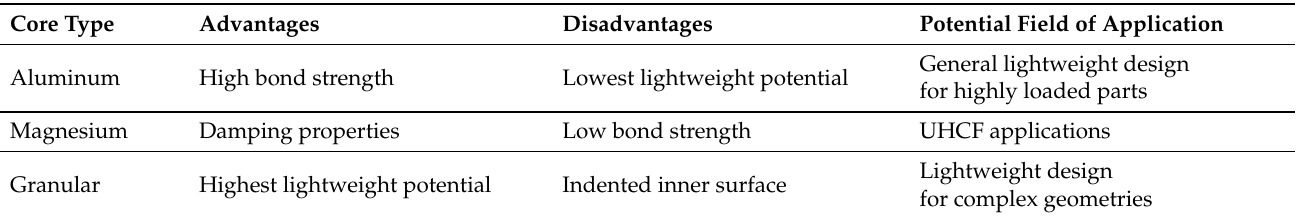
Table 4. Characteristics of different core materials used in composite forward rod